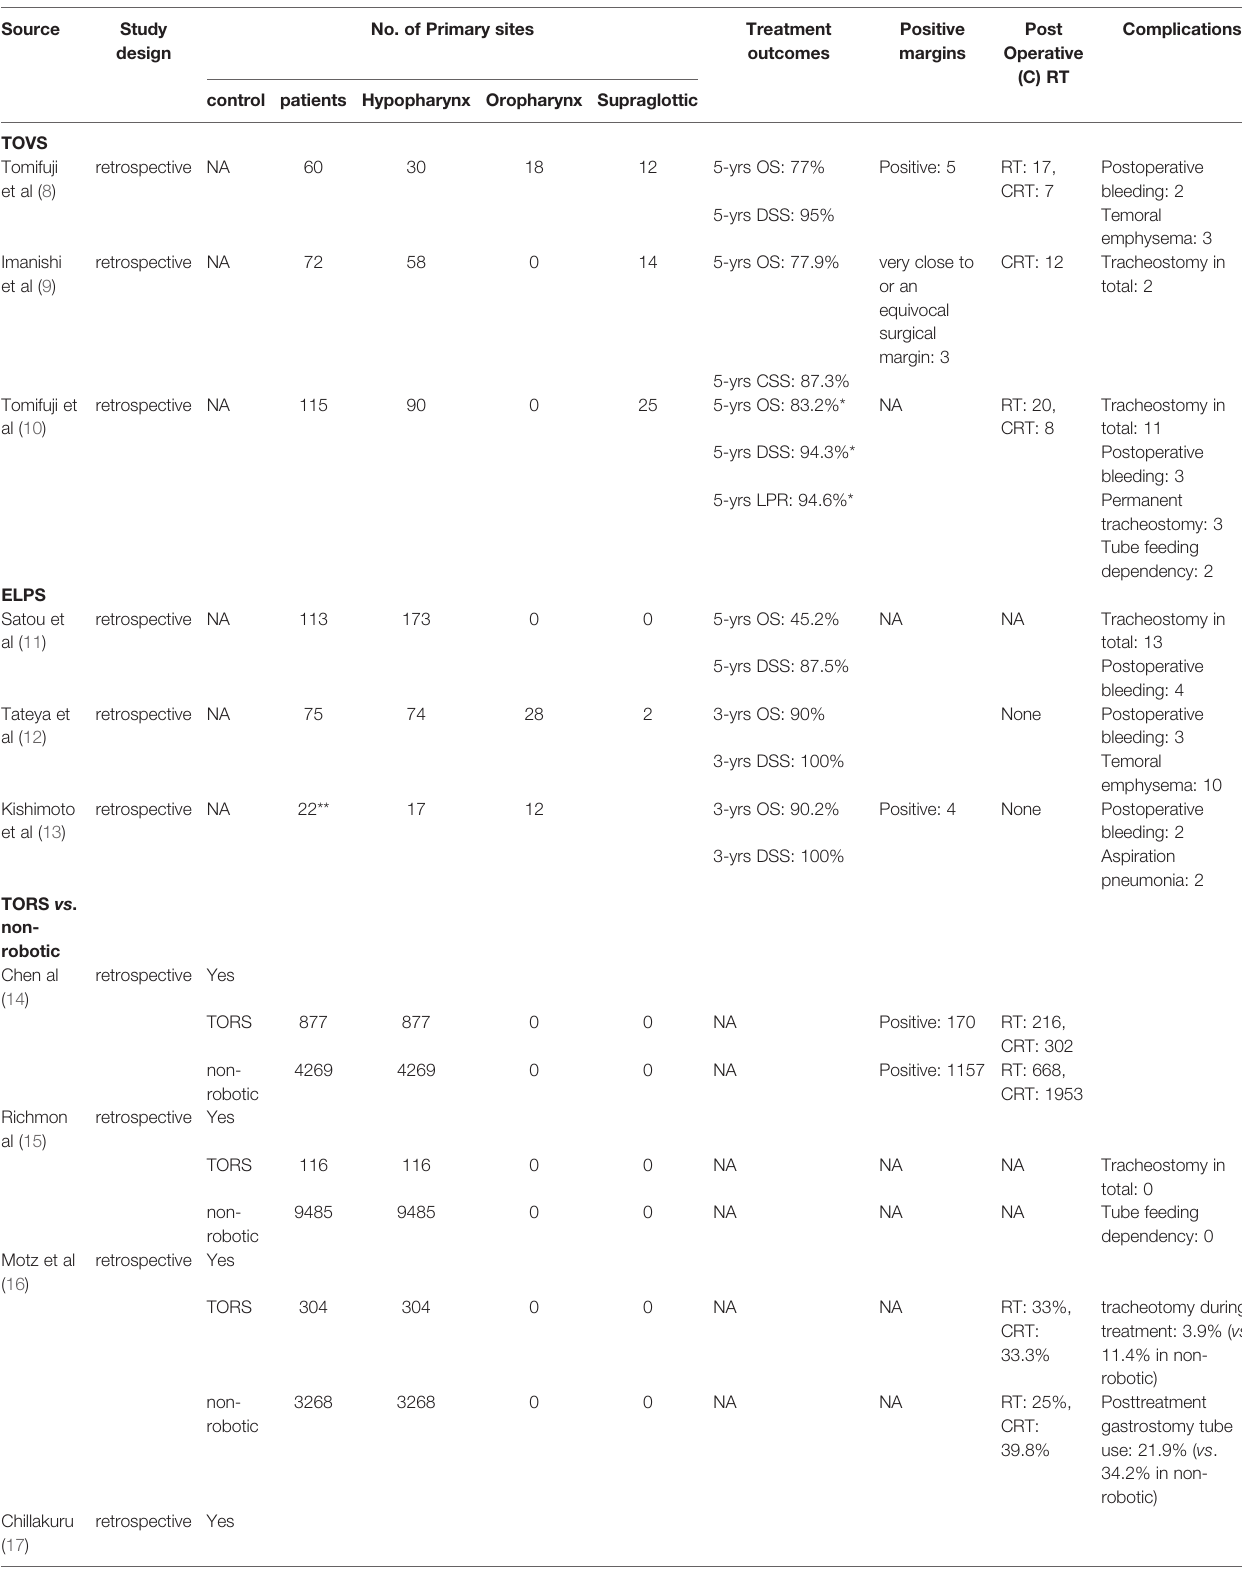
TABLE 1 | Treatment outcomes of TOVs, ELPs, and TORS.